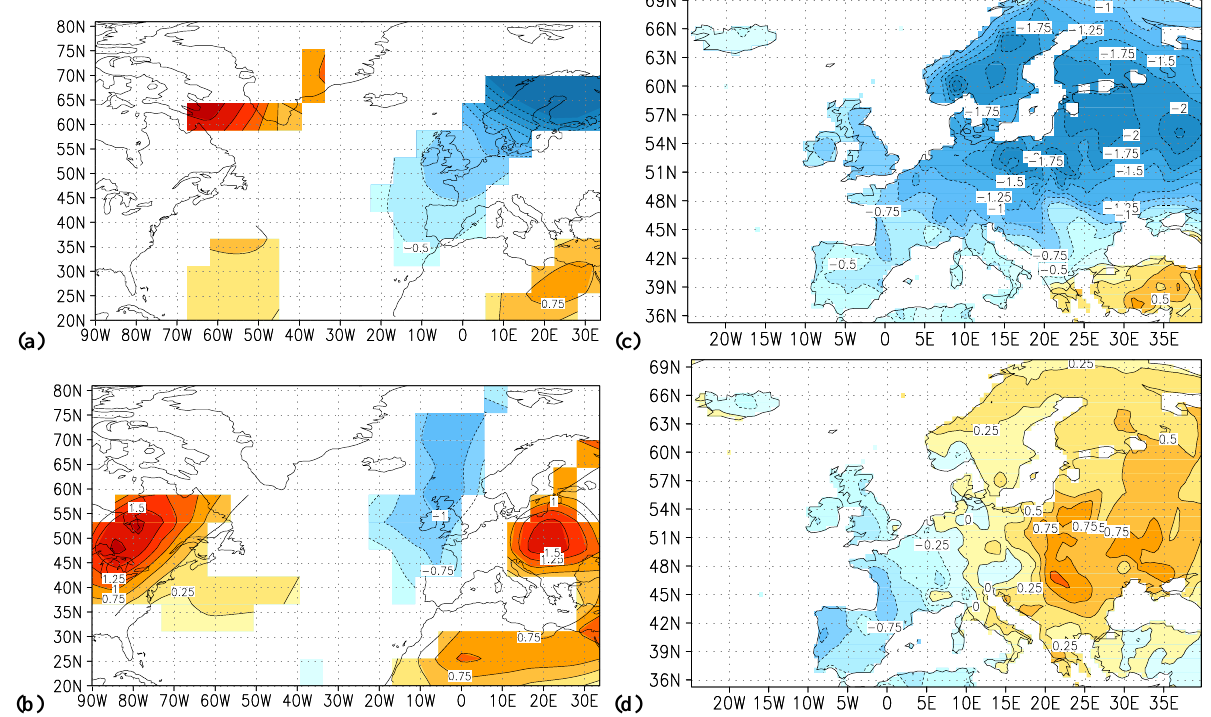
Fig. 4. Left-hand panels: difference in 2m temperature ( K ) between the data assimilated and the control run, averaged over 25 years, (a) winter (DJF) and (b) summer (JJA). All temperature changes shown are statistically significant at the 5% level. Right-hand panels: difference in reconstructed surface air temperature ( K ) for the period 1790–1820AD with respect to 1971–2000, (c) winter (DJF), and (d) summer (JJA). Reconstructed temperatures are from Luterbacher et al.